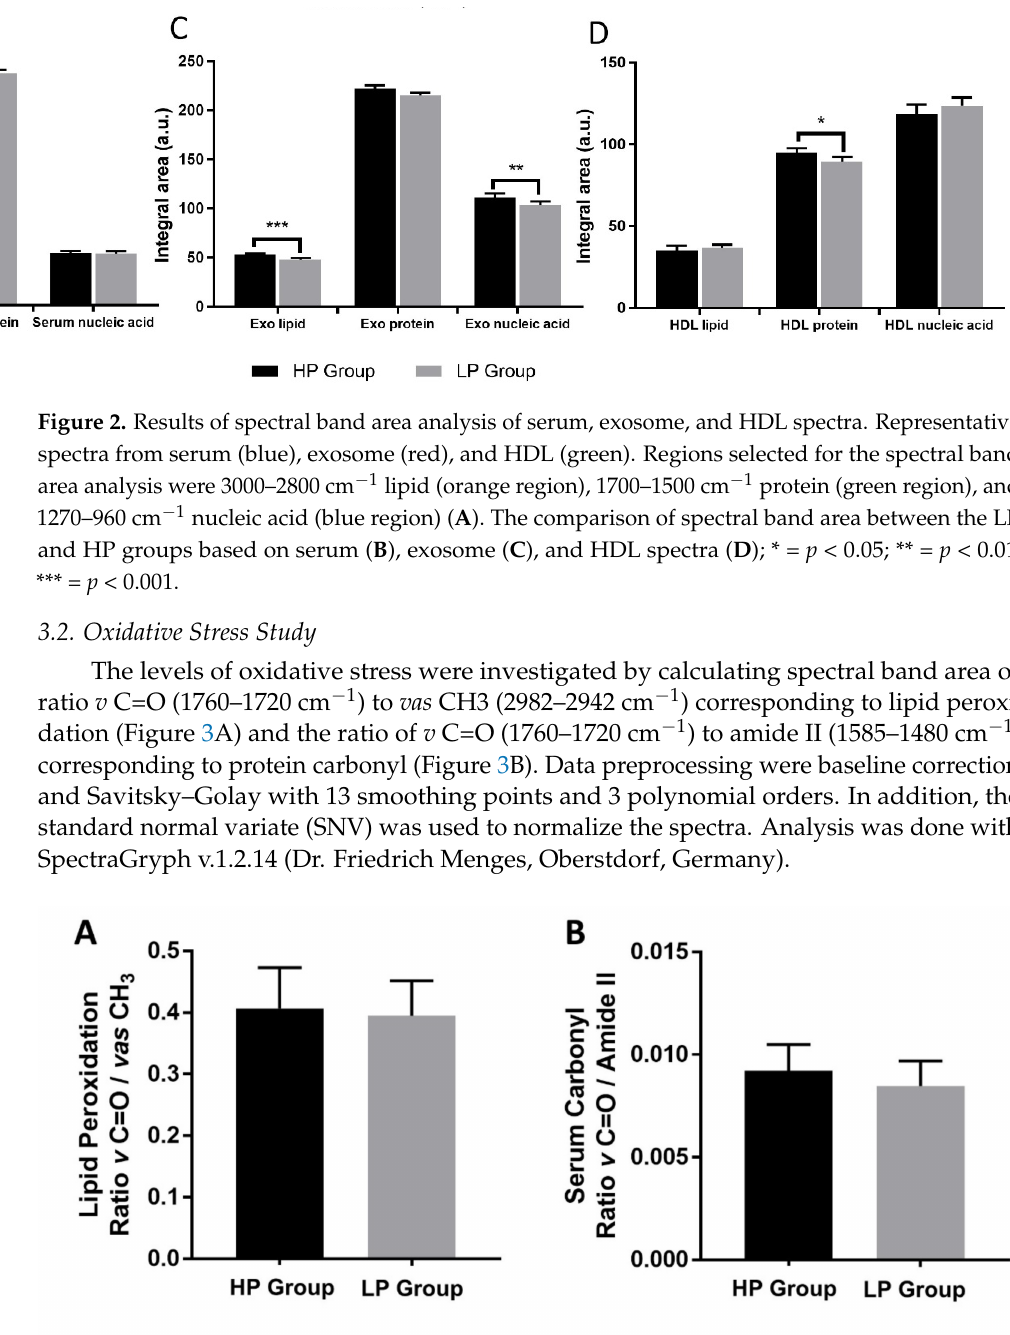
Figure 3. Oxidative stress levels based on the ratio of the spectral band area. A ratio of v C=O to vas CH 3 (lipid peroxidation) ( A ) and the ratio of v C=O to amide II (protein carbonyl) ( B ) All data are shown as median with 95%